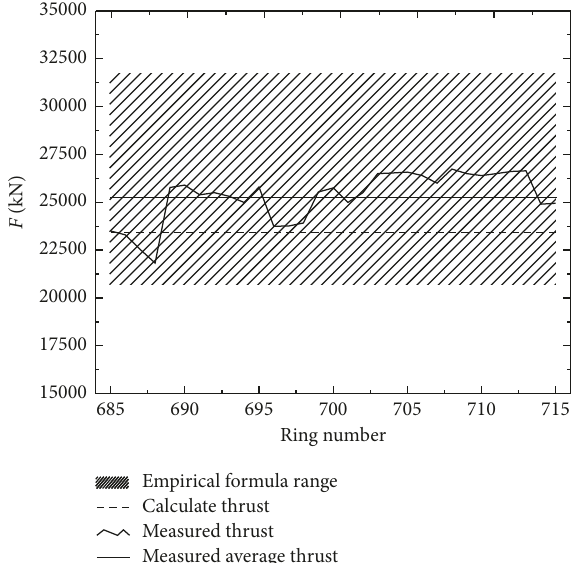
Figure 4: Comparison of total thrust during shield cutting piles.